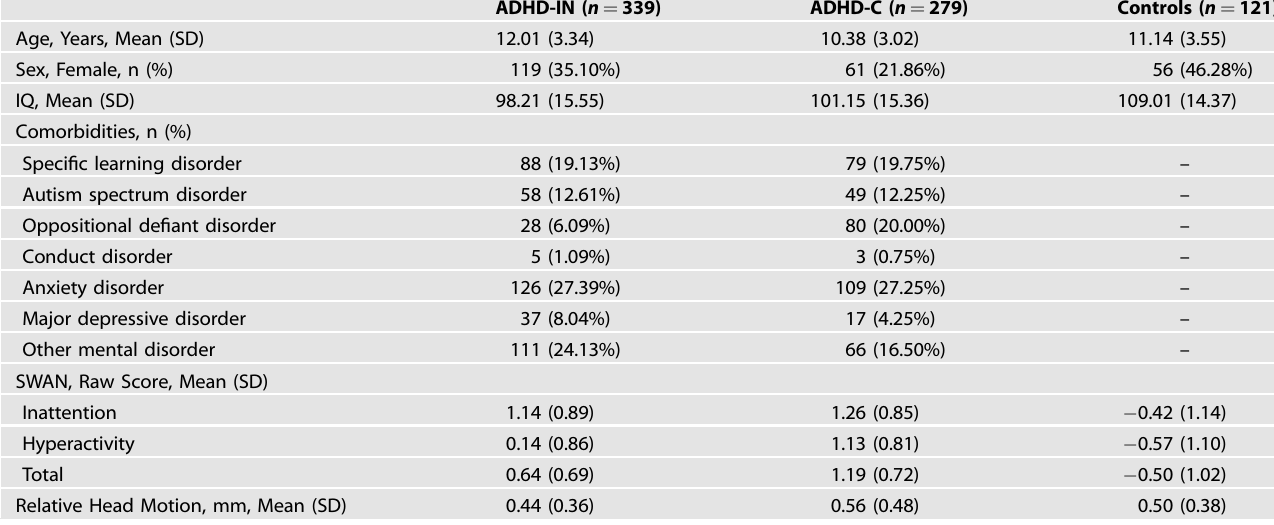
Table 1. Demographics, clinical characteristics, and head motion measures of the ADHD predominantly inattentive presentation, ADHD combined presentation, and control